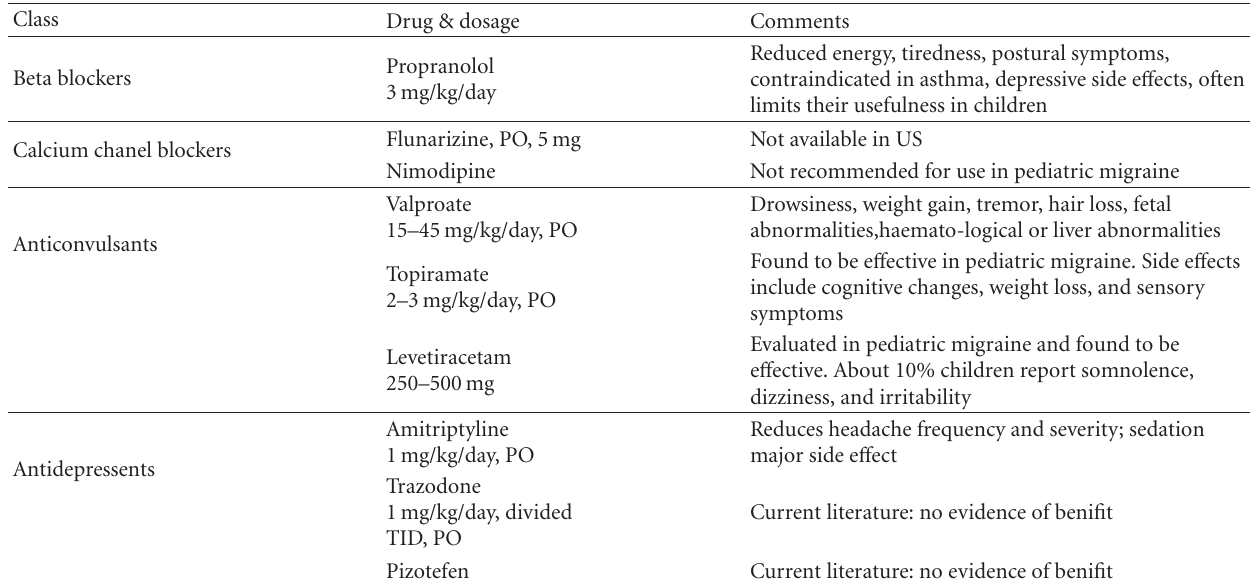
Table 6: Drugs used for prevention of migraine